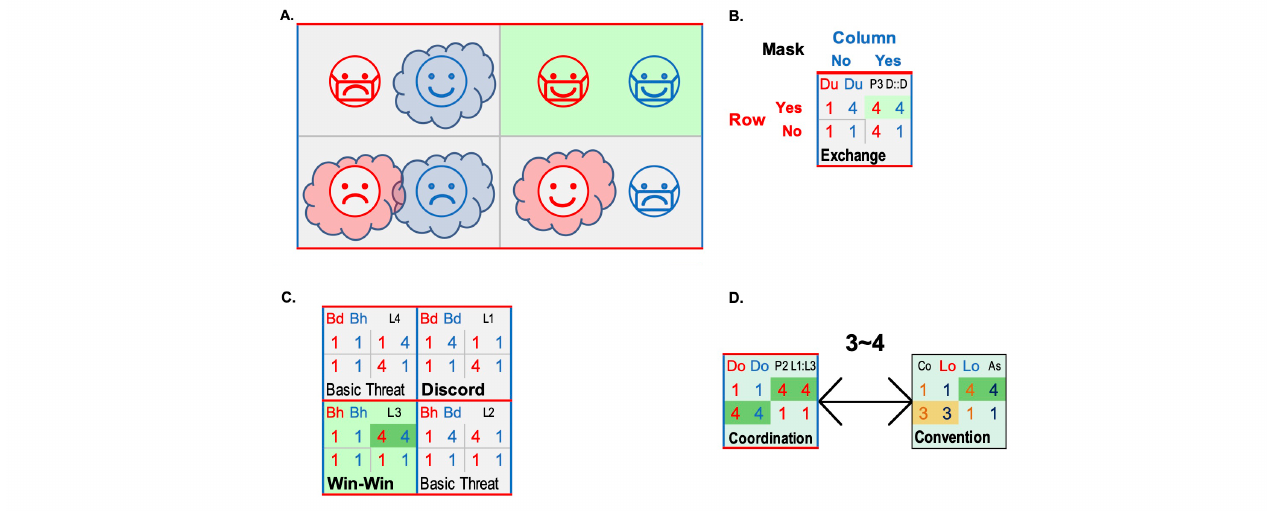
Fig. 1. Payoff matrices for simple 2 × 2 situations. (A) “My mask protects you, your mask protects me.” (B) Primal Exchange: payoff matrix for wearing a mask that only protects others, ranking of outcomes for row and column actors if only one’s own outcomes matter. (C) Basic archetypes with one preference each and ties (indifference) for the three lowest ranked outcomes. Payoffs from two symmetric games combine to form a pair of asymmetric threat games. (D) Breaking ties. Ranking one outcome lower (3,3) than the other (4,4) transforms Primal Coordination into Convention. In reverse, equalizing payoffs (making ties) simplifies Convention into Primal Coordination.